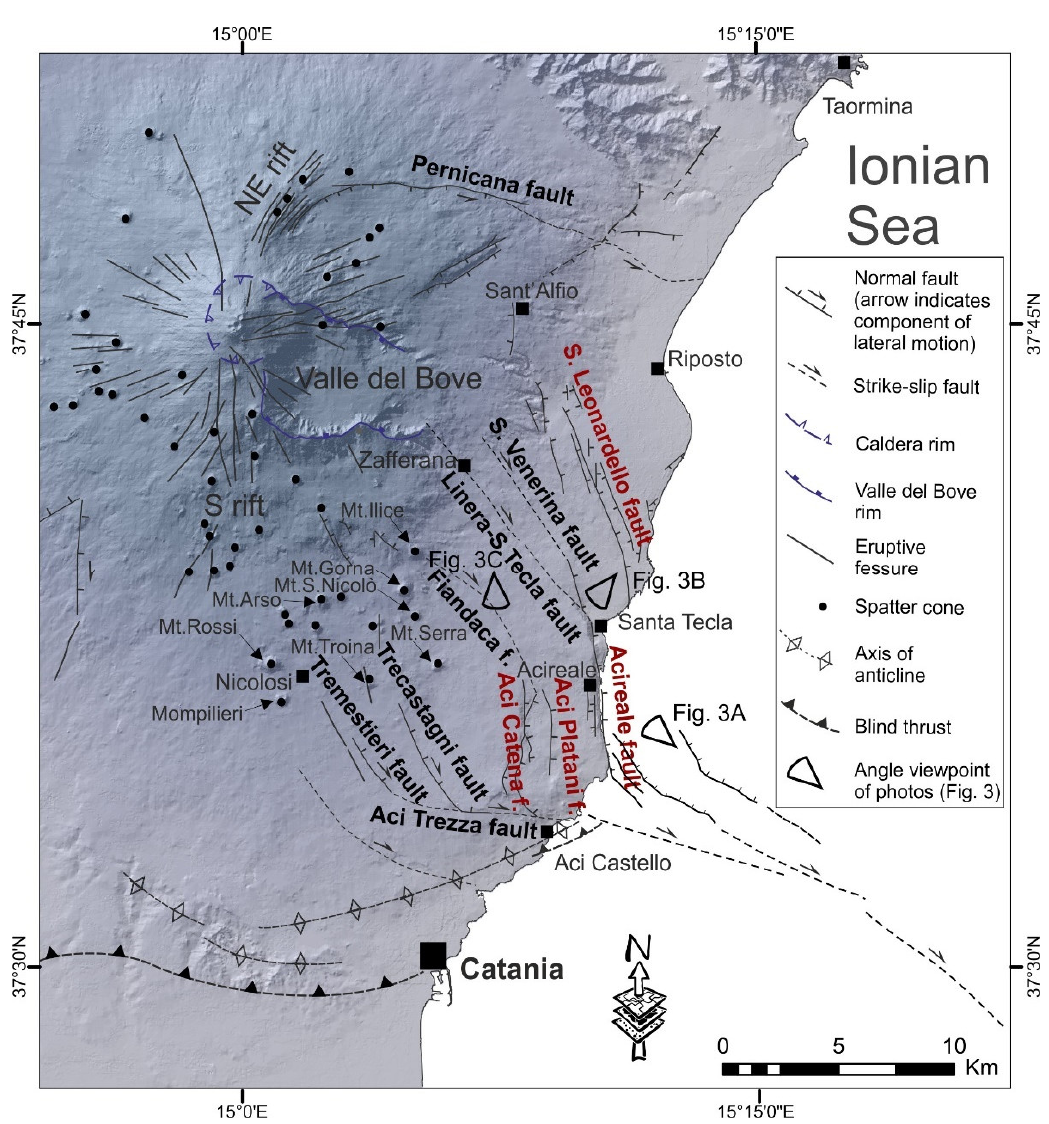
Figure 2. Structural map of Mt. Etna (from [18,22,47] modified; see location in Figure 1). Faults labelled in a red colour belong to the Timpe Fault System. The eastern sector of the Pernicana Fault and the Aci Trezza Fault aseismically transfer the extension towards the offshore and limit to the north and to the south, respectively, the sliding sector of the volcanic edifice (see [36]).